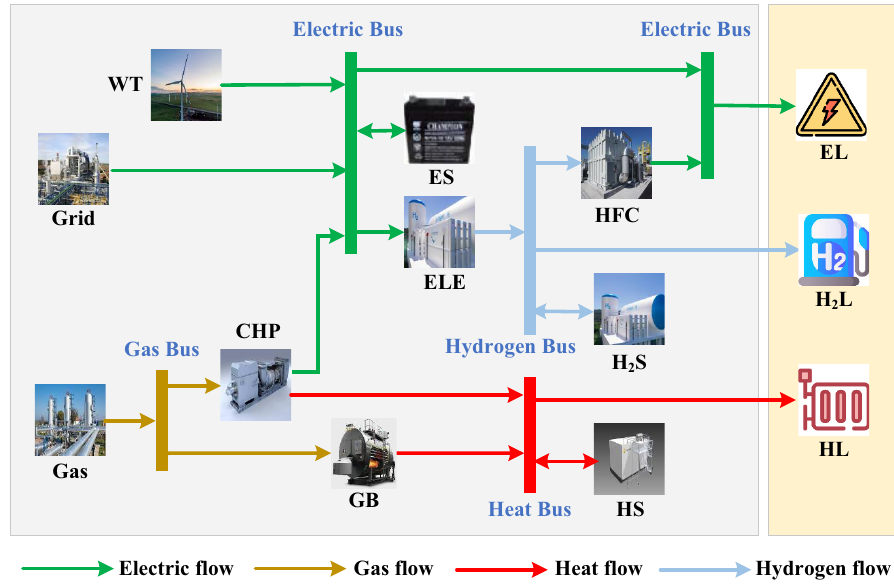
Figure 1. The basic structure of a multi-energy